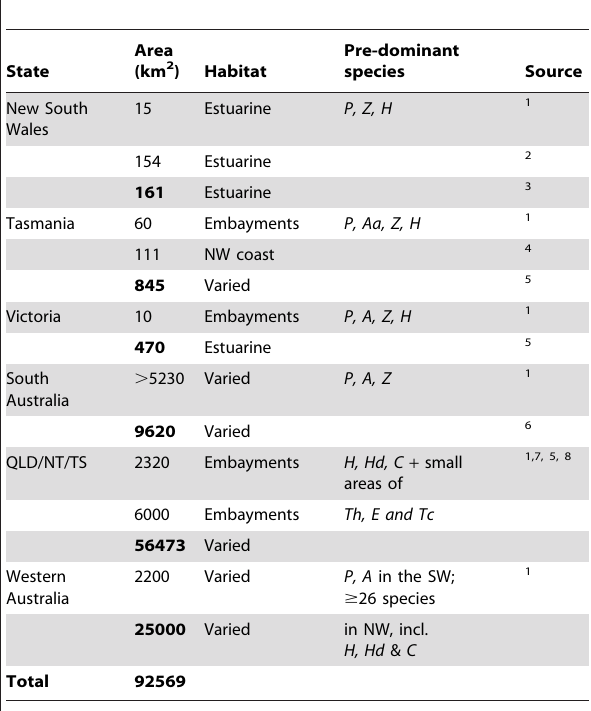
Table 2. Estimates of seagrass area in various region of Australia.